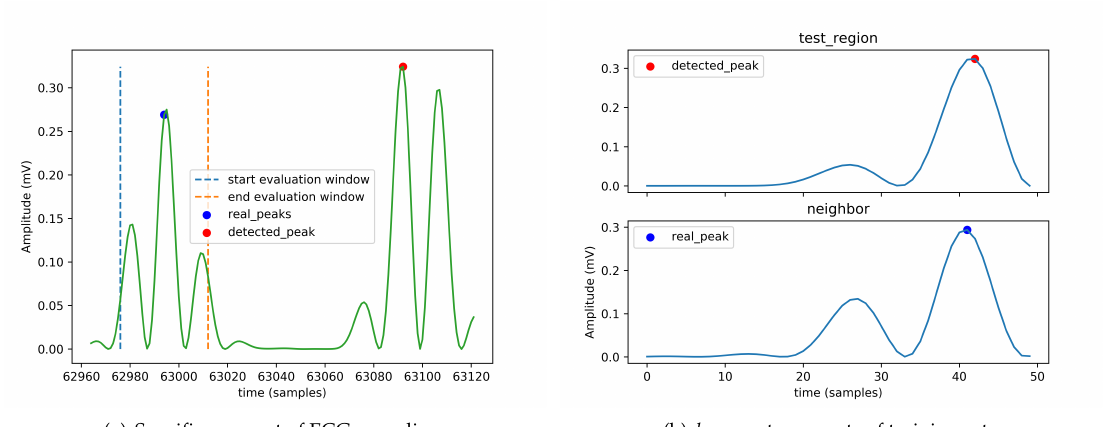
Figure 4. Fine tuning of the performance of the heartbeat detection module by evaluating the achieved precision, recall and F1 score when using different training set lengths ( t ) expressed as a percentage of the total size of the ECG recording and different window sizes.